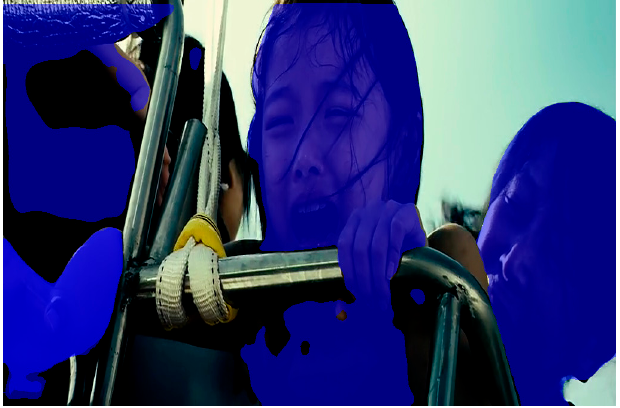
Figure 11. Frame with an Error in Shot Type Classification.